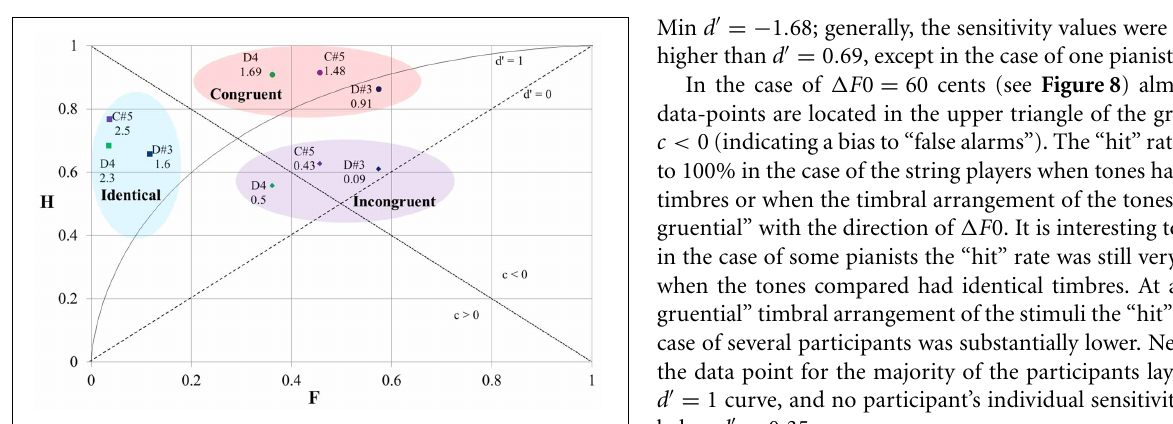
FIGURE 5 | The results of the SDT analysis of the pooled responses for stimuli by three different pitch regions (around D#3, D4, and C#5). The location of the data-point on the graph depends on the timbral arrangement of the comparable tones (the three colored ovals). The numbers on the graph correspond to the values of d (cid:2)